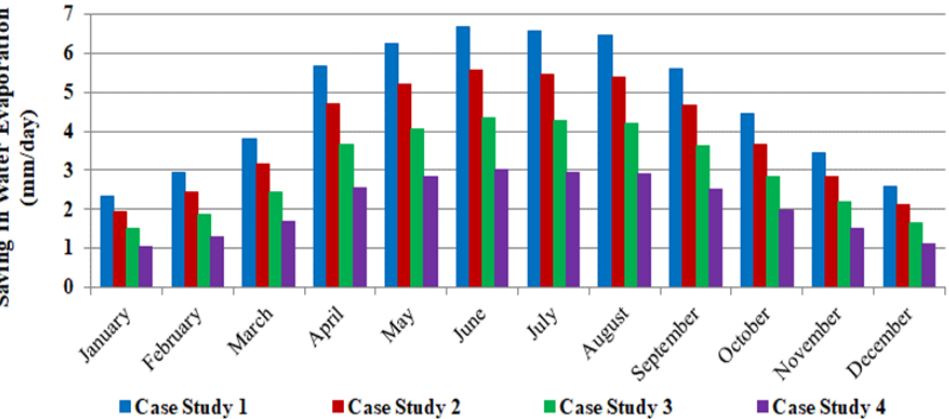
Figure 6. Average daily evaporation savings for each month of the year during the installation of FPV panels on Lake Nasser.